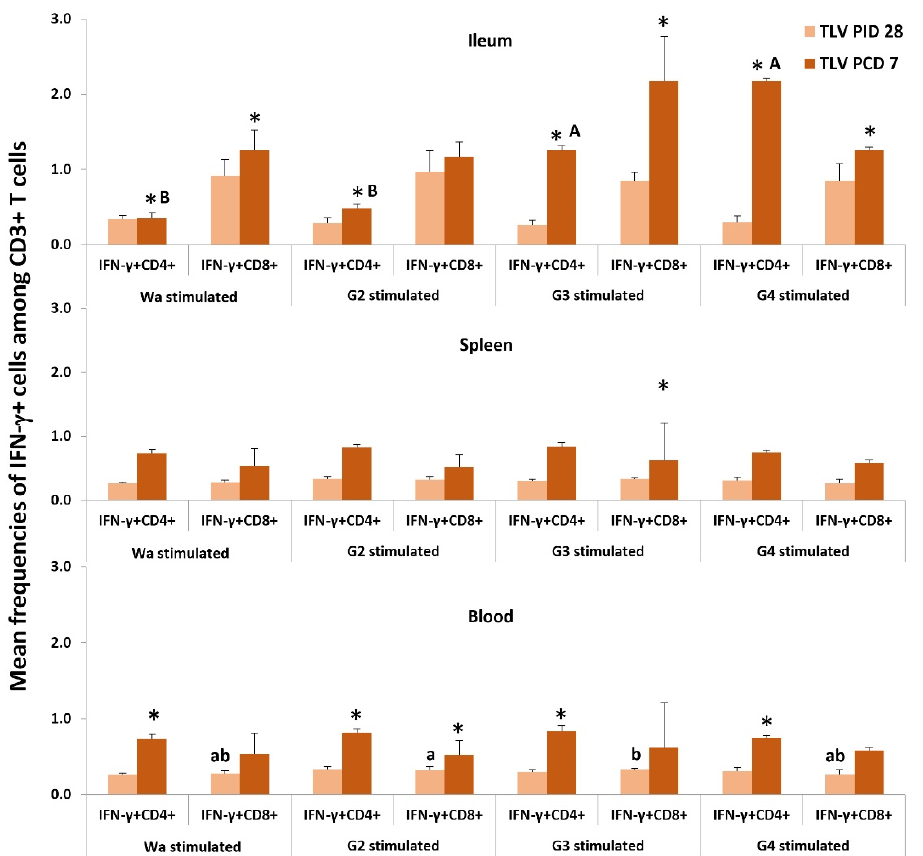
Figure 10. Frequencies of IFN- γ +CD4+ and IFN- γ +CD8+ T cells in the intestinal and systemic lymphoid tissues pre- and postchallenge in the TLV vaccinated Gn pigs detected by flow cytometry. The MNC were stimulated in vitro for 17 h with semi-purified whole Wa HRV, G2, G3, or G4 VP7 antigens. * Indicates a significant difference compared between PID 28 and PCD 7 for the same cell type. Different letters on the bars indicate significant differences between different antigen stimulation for IFN- γ +CD4 T cells (capital letters A, B) and IFN- γ +CD8 T cells (lowercase letters a, b); while shared letters indicate no significant difference at the same time point (Kruskal–Wallis test, p < 0.05).